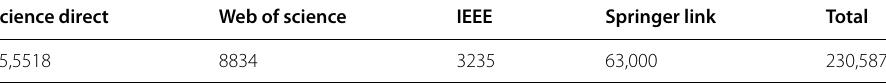
Table 3 Design Development stage Science direct